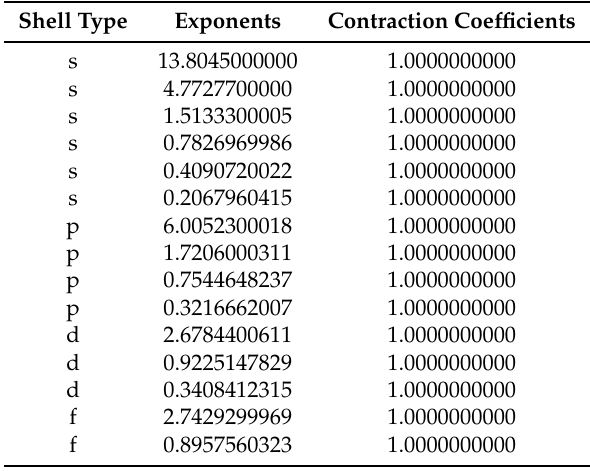
Table A18. Parameters of the cc-DZVP auxiliary basis set of Carbon. Parameters taken from [89].